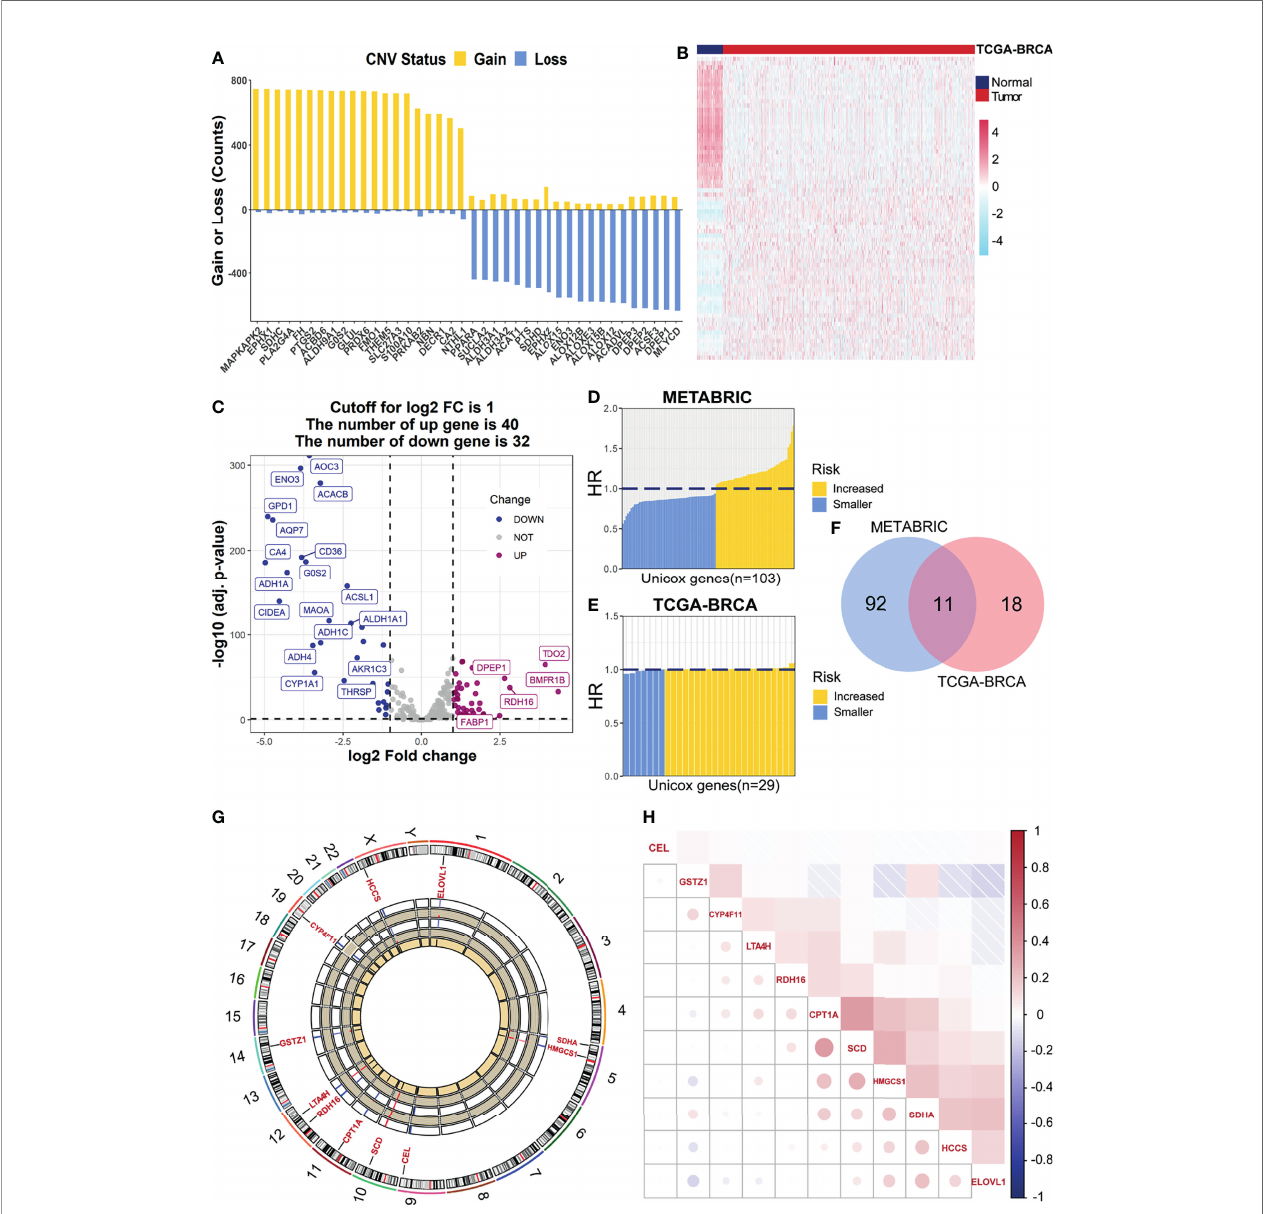
FIGURE 1 | Identi fi cation of prognostic FMGs in BC patients. (A) The CNV frequency of FMGs in TCGA-BRCA cohort. (B) Heatmap of 72 differentially expressed genes from FMGs. (C) Volcano plot exhibiting 72 DEGs among FMGs. (D) One hundred three prognostic FMGs in METABRIC dataset. (E) Twenty-nine prognostic FMGs in TCGA-BRCA dataset. (F) Venn diagram to identify 11 overlapping prognostic FMGs. (G) The circos plot depicting the location on chromosomes and expression level of 11 prognostic FMGs. (H) The correlation matrix plot displaying the correlation features among 11 prognostic FMGs in TCGA-BRCA. FMGs, fatty acid metabolism-related genes; BC, breast cancer; CNV, copy number variation; DEGs, differentially expressed genes; TCGA, The Cancer Genome